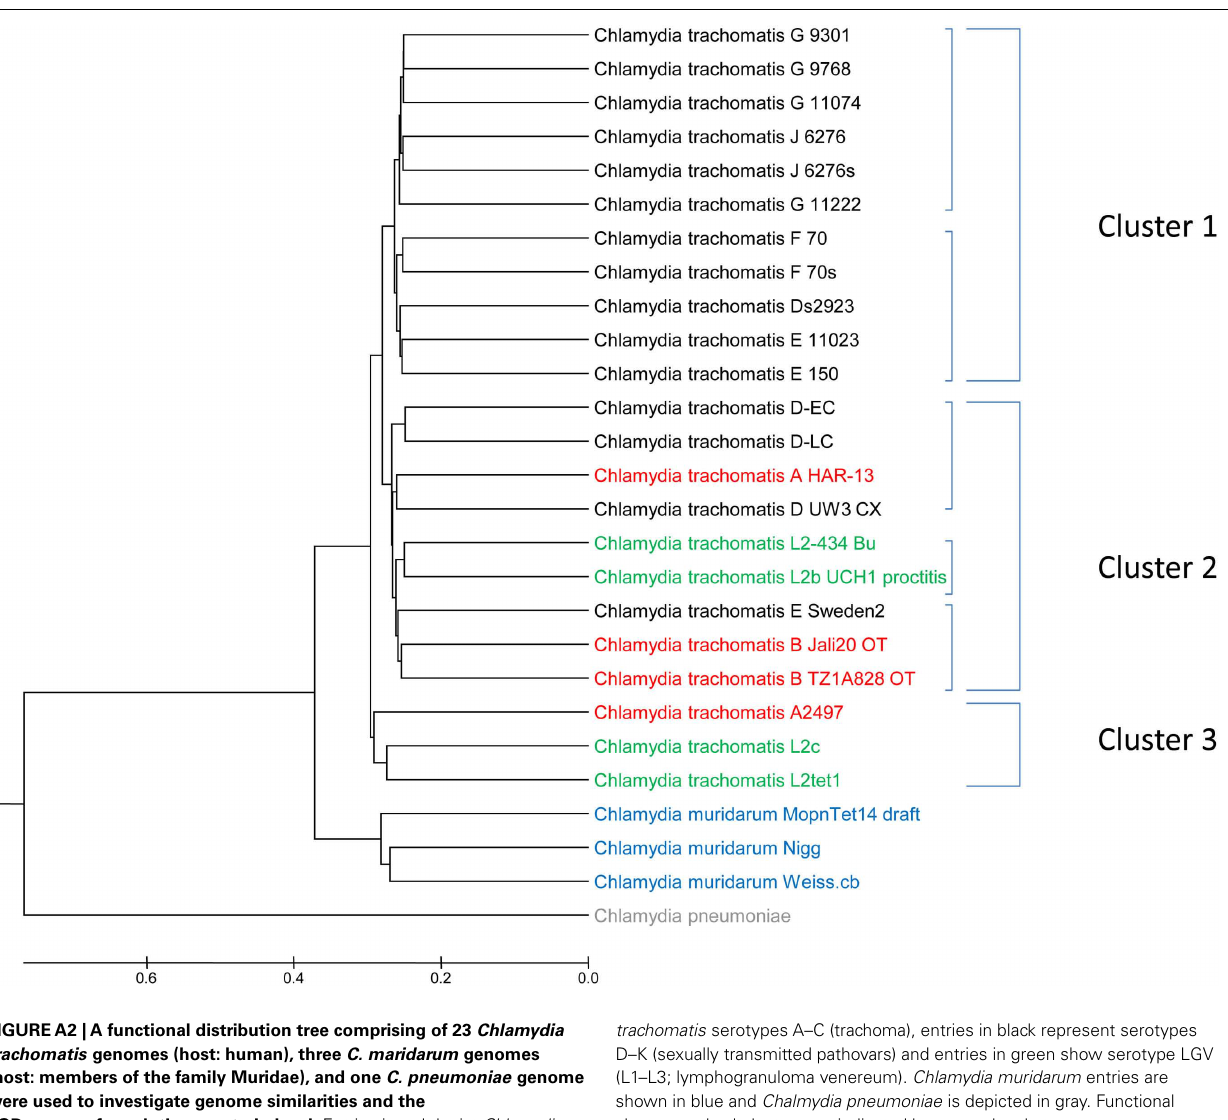
trachomatis serotypes A–C (trachoma), entries in black represent serotypes D–K (sexually transmitted pathovars) and entries in green show serotype LGV (L1–L3; lymphogranuloma venereum). Chlamydia muridarum entries are shown in blue and Chalmydia pneumoniae is depicted in gray. Functional clusters and subclusters are indicated by square